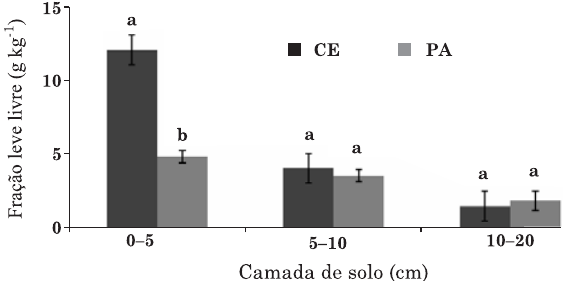
Figura 1. Fração leve livre da matéria orgânica do solo (FLL) de um Latossolo Vermelho sob Cerradão (CE) e pastagem (PA) em Rio Verde (GO) (n=6). Letras iguais dentro de uma mesma camada de solo não diferem pelo teste de Tukey (p < 0,05).